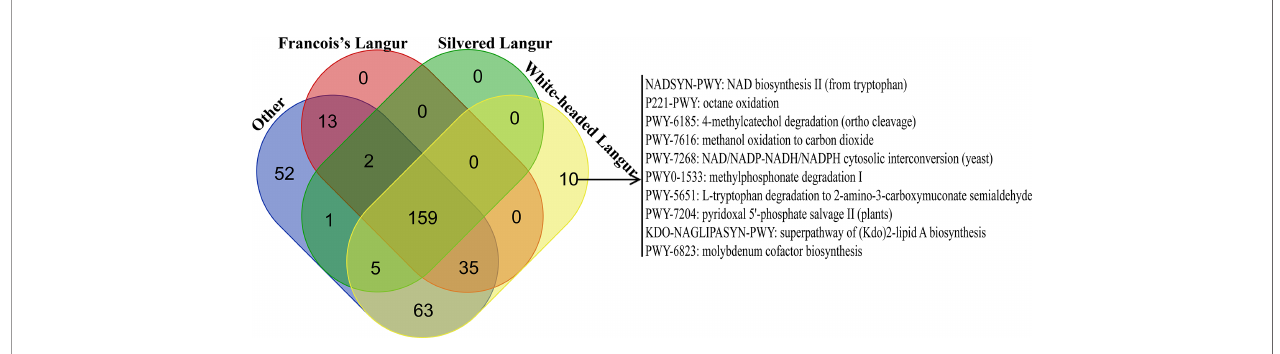
FIGURE 7 | Venn diagram of functional pathway in all primates. Other included loris, pygmy lorises, ring-tailed lemur, macaques, gibbon, and